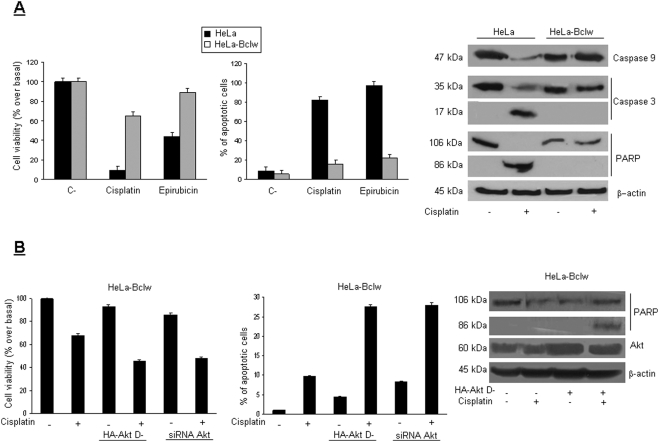
Akt regulates the anti-apoptotic function of Bcl-w.(A) HeLa control cells and HeLa cells stably expressing Flag-Bcl-w were plated in 96 well plates in triplicate and treated with 30 µg/ml of cisplatin or 10 µg/ml of epirubicin for 24 hr. Apoptosis was analyzed by Cell Vitality assay, by propidium iodide staining and FACS analysis, or by western blot for caspase cascade activation with anti-caspase-3, -9, and PARP antibodies. Loading control was obtained with anti β-actin. (B) HeLa-Flag Bcl-w cells were transfected with 4 µg of HA-Akt D− cDNA or with 100 nM of siAkt-RNA for 48 hrs and then treated with 30 µg/ml of cisplatin for 24 hr. Cell death was then analyzed as described above. Total lysates were analyzed by western blot using an anti-PARP antibody. Loading control was obtained with an anti-β-actin antibody. Inactivation of Akt activity resulted in a reduction in the protective effect of Bcl-w on cell death.